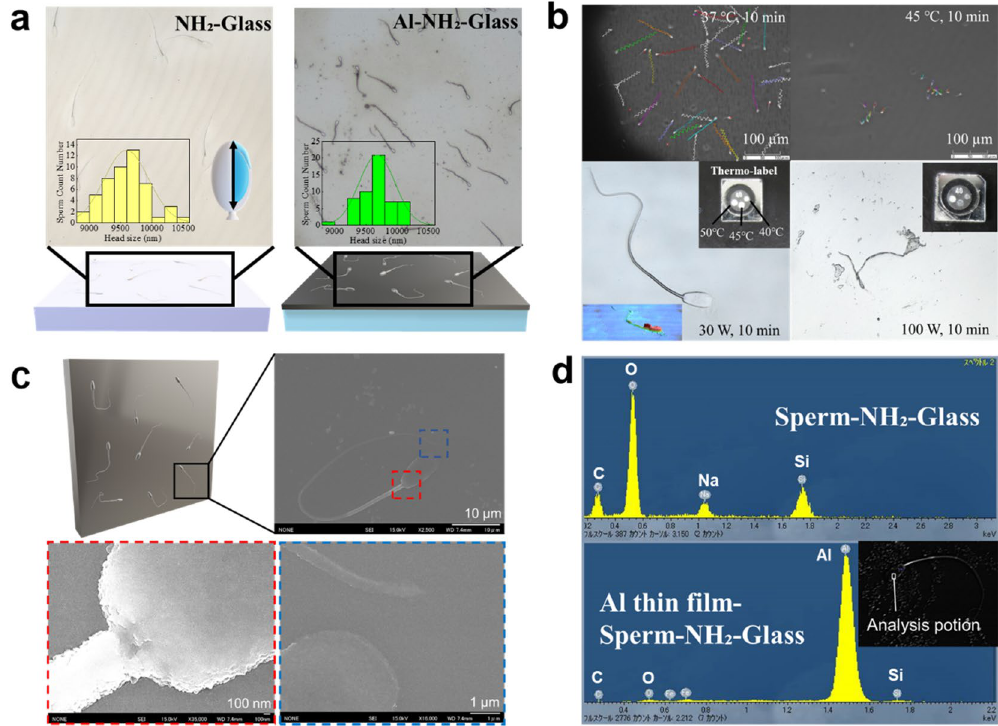
Figure 2. Deposition of Al thin film using non-heat damage technique. ( a ) Glass after sperm adsorption and deposition of Al thin film; laser microscopy imaging was conducted using high magnification. Inset graphs show the result of optical analysis of the sperm head size from tip to neck. ( b ) Motility of spermatozoa was analysed after incubation at 37 °C and 45 °C for 10 min. Films were deposited under temperature conditions conforming to respective results, and the effect of thermal denaturation on sperm shape was observed. ( c ) Scanning electron microscopy images showing sperm from head to tail after Al thin film deposition. ( d ) Elemental analysis of the sperm-glass and sperm heads for